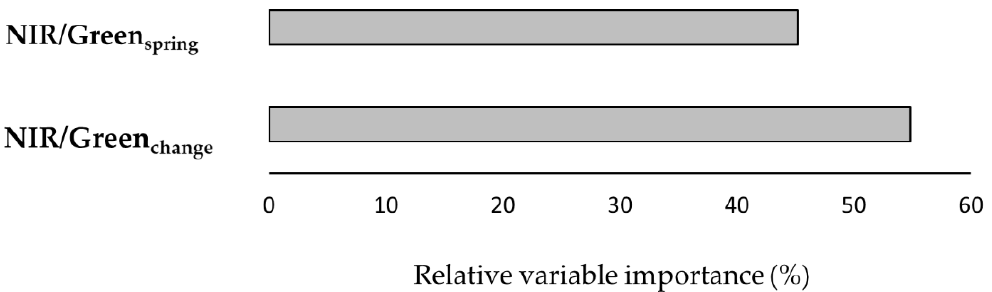
Figure 6. The importance of predictor variables for the explanation of plant species richness in the species–energy model, the most supported spatial pathway (P2). Table 1. Results of the multi − model selection approach with the three different spatial pathways evaluated to monitor plant species richness in the grassland parcels of Peneda − Gerês, Portugal ( n = 24). Model selection was performed using generalized linear models with a Poisson distribution of errors and the Akaike information criteria corrected for small sample sizes (AICc) to identify and rank the pathways. Pathways with Δ AICc ≤ 2.0 were considered models receiving strong support. a